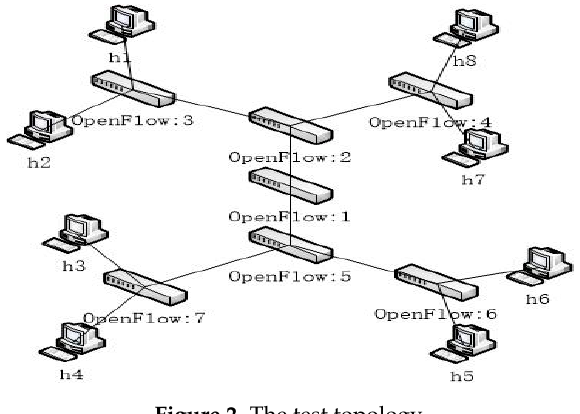
Figure 2. The test Figure 2. The test topology.